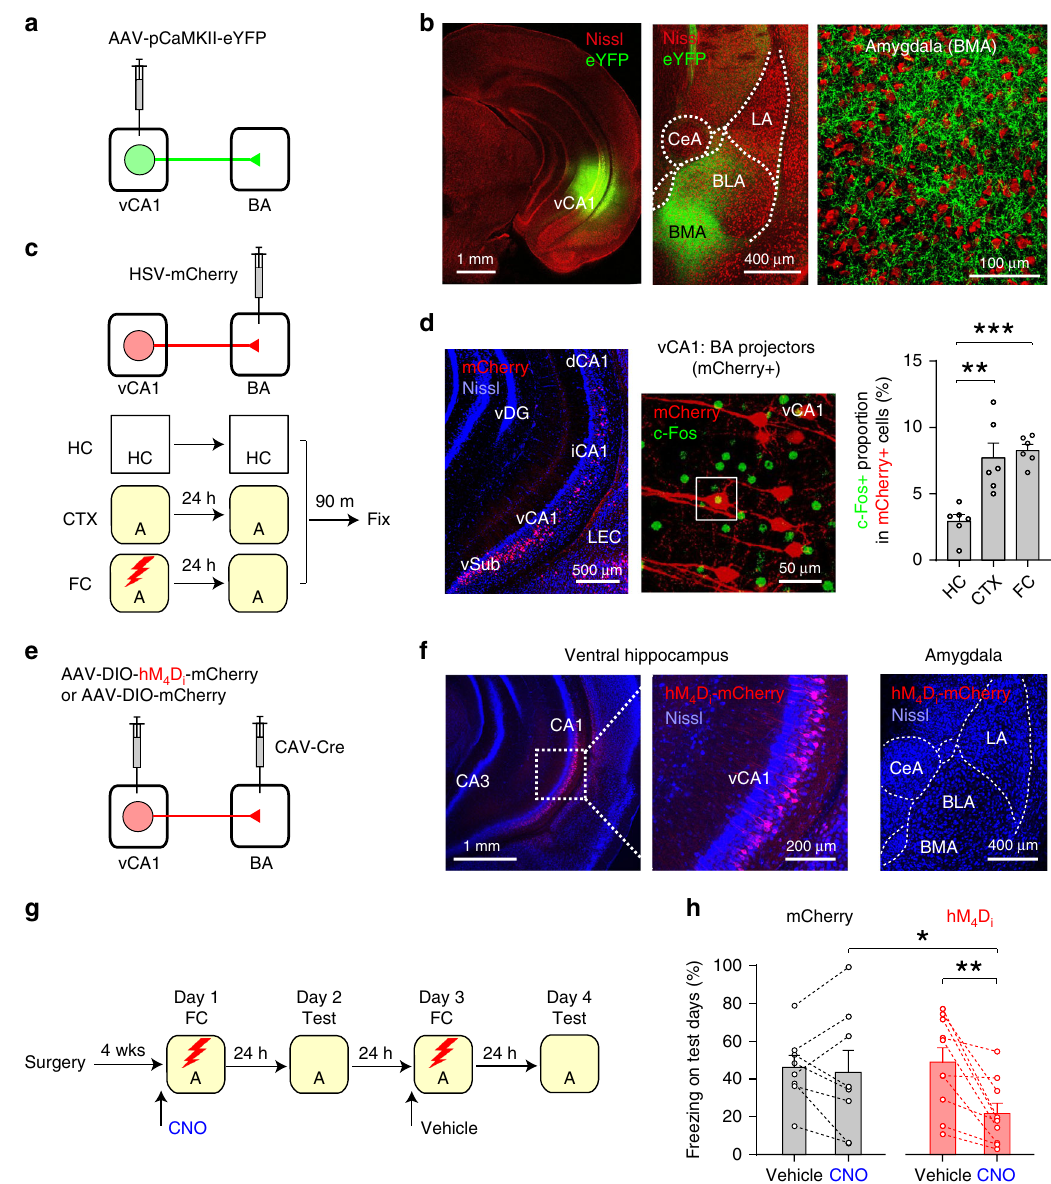
Fig. 1 Activity in the vCA1 – BA pathway contributes to the acquisition of contextual fear memory. a Experimental setup for b . b Images showing eYFP expression in the vCA1 (left, green) and eYFP-labeled vCA1 axons in the amygdala (middle and right). Red, Nissl stain. LA, BLA, BMA, and CeA: lateral, basolateral, basomedial, and central nuclei of the amygdala, respectively. c Experimental setup for d . Top: vCA1 neurons projecting to the BA (vCA1: BA projectors) were retrogradely labeled with HSV-mCherry. Bottom: mice in FC group were fear conditioned in Context A as in Supplementary Fig. 1a. Mice in CTX group were exposed to Context A without a US. After 24 h, they were tested for freezing behavior in Context A. Brain tissues were then fi xed 90 min later for c-Fos immunohistochemistry. Mice in HC group were left in their home cages until brain fi xation. d Left: image showing vCA1: BA projectors